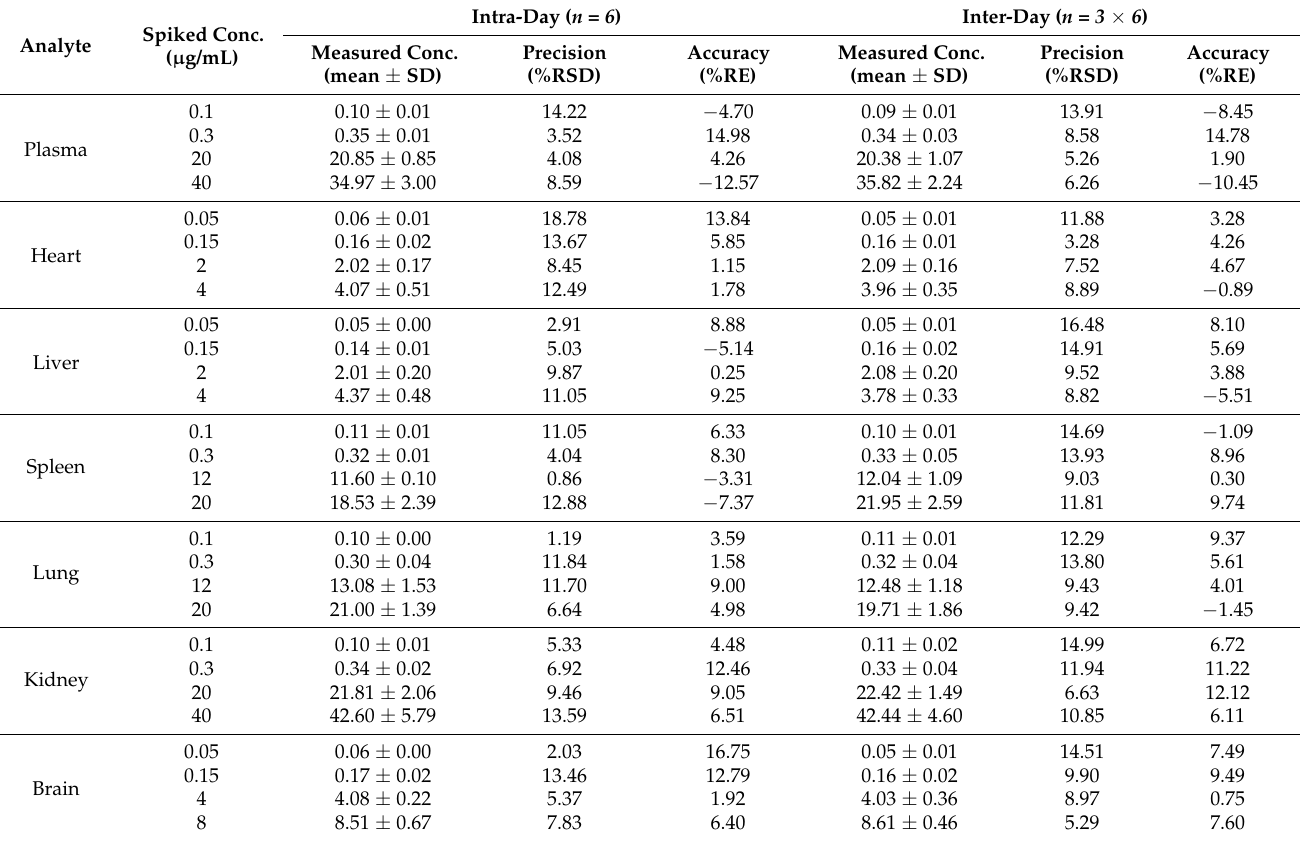
Table 3. Precision and accuracy for the analysis of